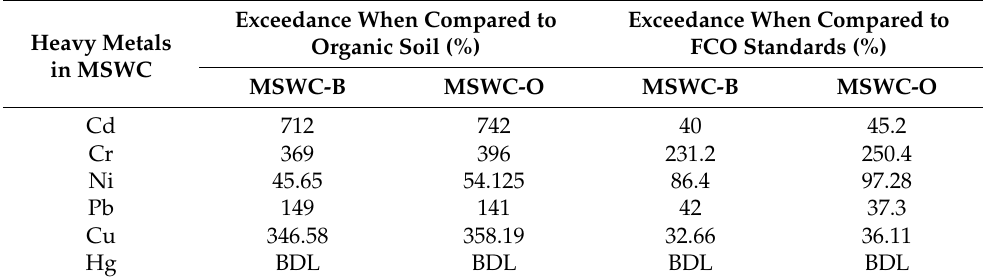
Table 5. Percentage showing exceedance in metal concentrations in MSWC when compared to permissible limits of soil and FCO standard